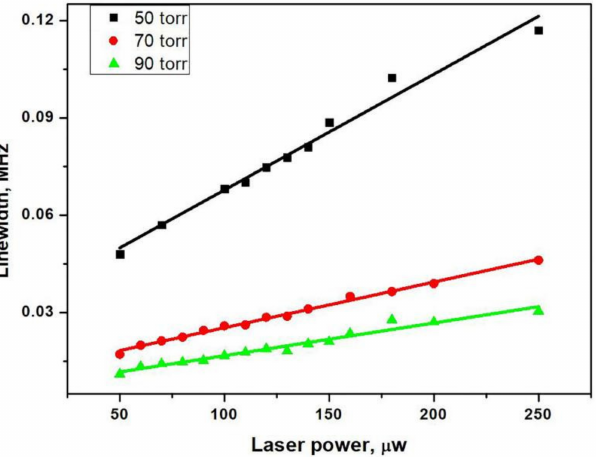
Figure 8. CPT linewidth as a function of laser power at different pressure (50–70–90 Torr) and the linear fitting